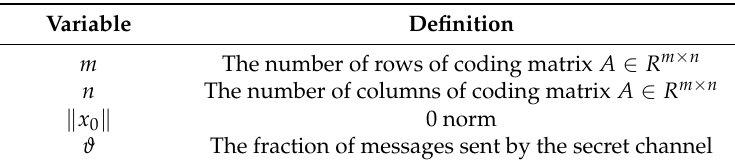
Table 1. Terms used in the experiment.